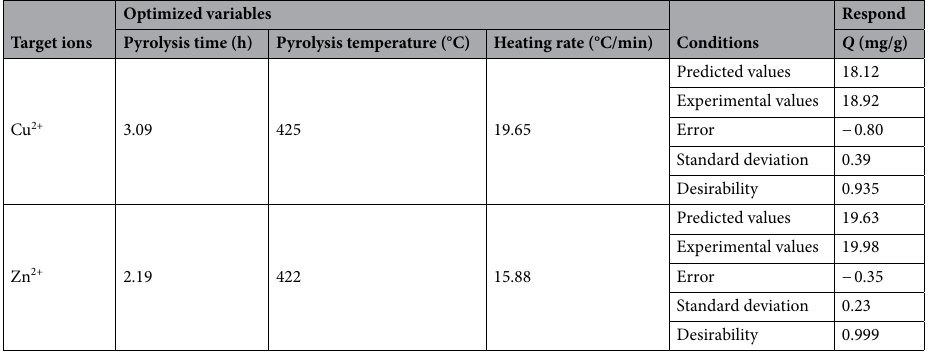
Table 5. Model validation of predicted and experimental result.